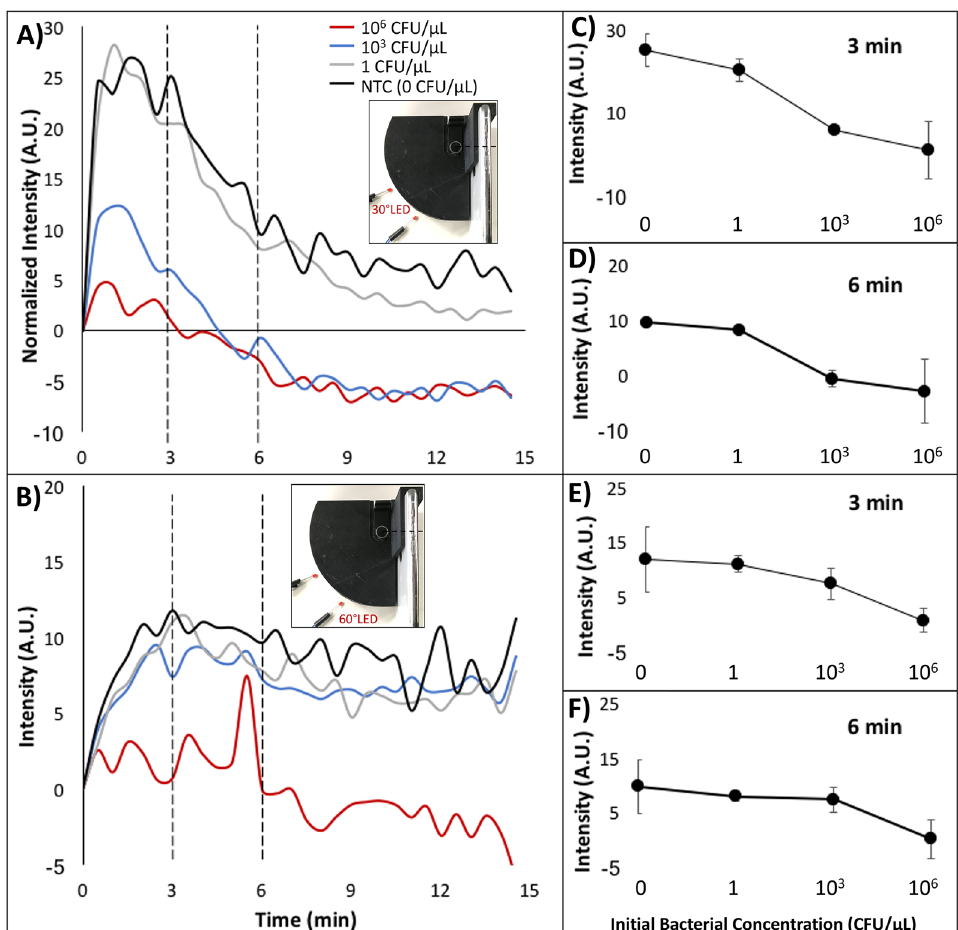
Figure 5. Emulsion LAMP light scatter intensity via smartphone camera over time at ( A ) 30° and ( B ) 60° angle with respect to 650 nm incident wavelength with varying initial bacteria concentration of 10 6 , 10 3 , 1, and 0 CFU/ µL. A and B are the representatives chosen from 3 replicates for each concentration. 30° light scatter red channel intensity at ( C ) 3 min and ( D ) 6 min. 60° light scatter red channel intensity at ( E ) 3 min and ( F ) 6 min with bacteria concentrations of 10 6 , 10 3 , 1, and 0